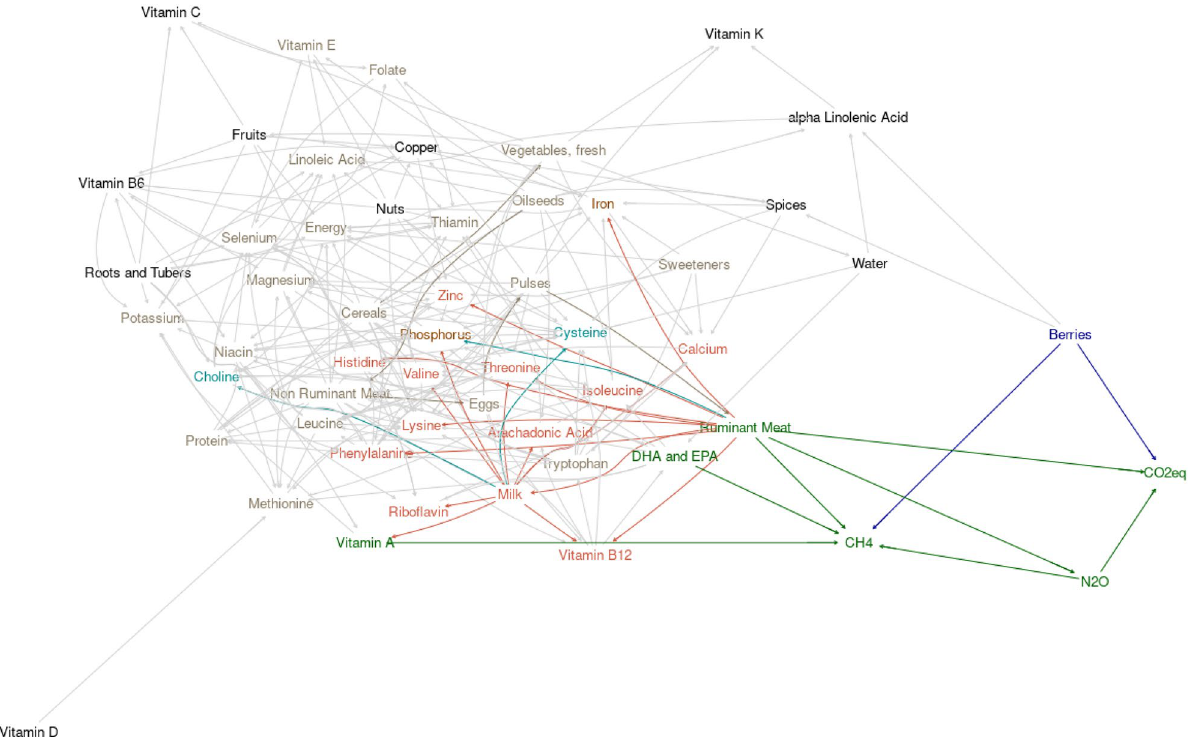
Figure 3. Bayesian learning network relating individual country yearly average production of different categories of foods (total mass produced), production of different nutrients and energy (total amount produced), and agricultural production of methane (CH 4 ), nitrous oxide (N 2 O), and carbon dioxide equivalent (CO 2 eq), and agricultural water use. Nodes are colored to highlight the relationships revealed by exploring the Markov blankets of CO 2 eq, CH 4 and N 2 O. Navy nodes and edges show indirect conditional dependencies driving CO 2 eq, CH 4 and N 2 O. Green nodes and edges show direct conditional dependencies driving CO 2 eq, CH 4 and N 2 O. Red nodes reflect nutrients expected to decrease if ruminant meat was targeted as a strategy to decrease greenhouse gas emissions. Light blue nodes reflect those expected to increase if ruminant meat was targeted as a strategy to decrease greenhouse gas emissions. The variables highlighted in the tan colors show the broader nutrient blanket expected to be conditionally dependent on ruminant meat and milk production but through more than 1 degree of